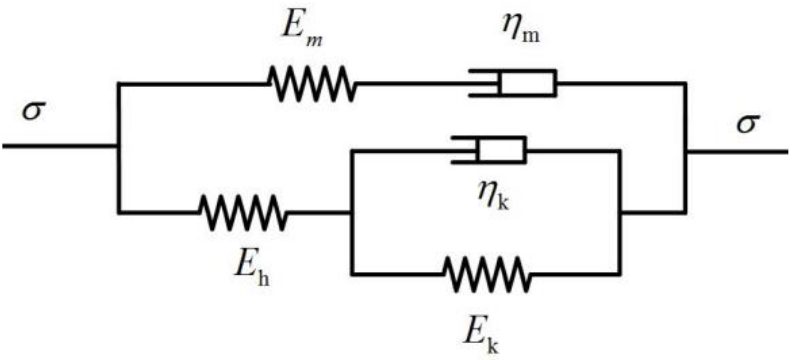
Figure 3. General Kelvin and Maxwell parallel coupled creep model.